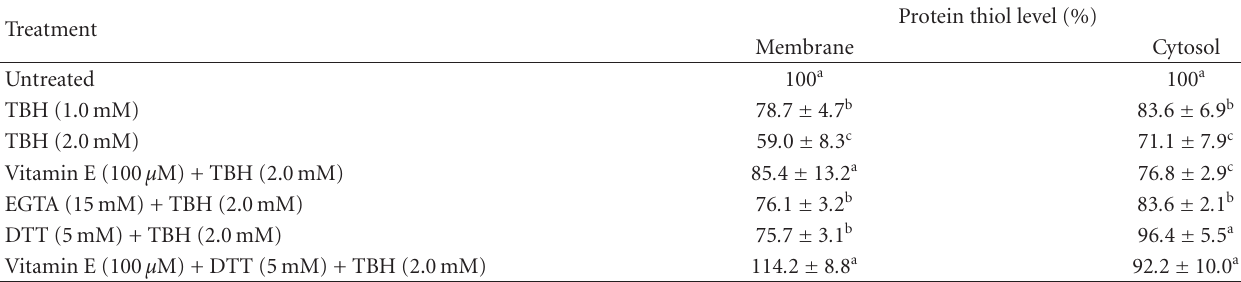
Table 2: E ff ect of vitamin E and DTT on the loss of membrane protein thiols in TBH-treated hepatocytes 60min after treatment.